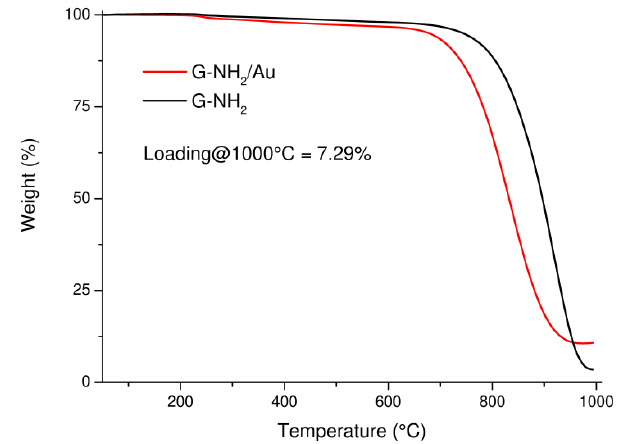
Figure 3. TGA profiles of G-NH 2 and G-NH 2 /Au under air atmosphere.